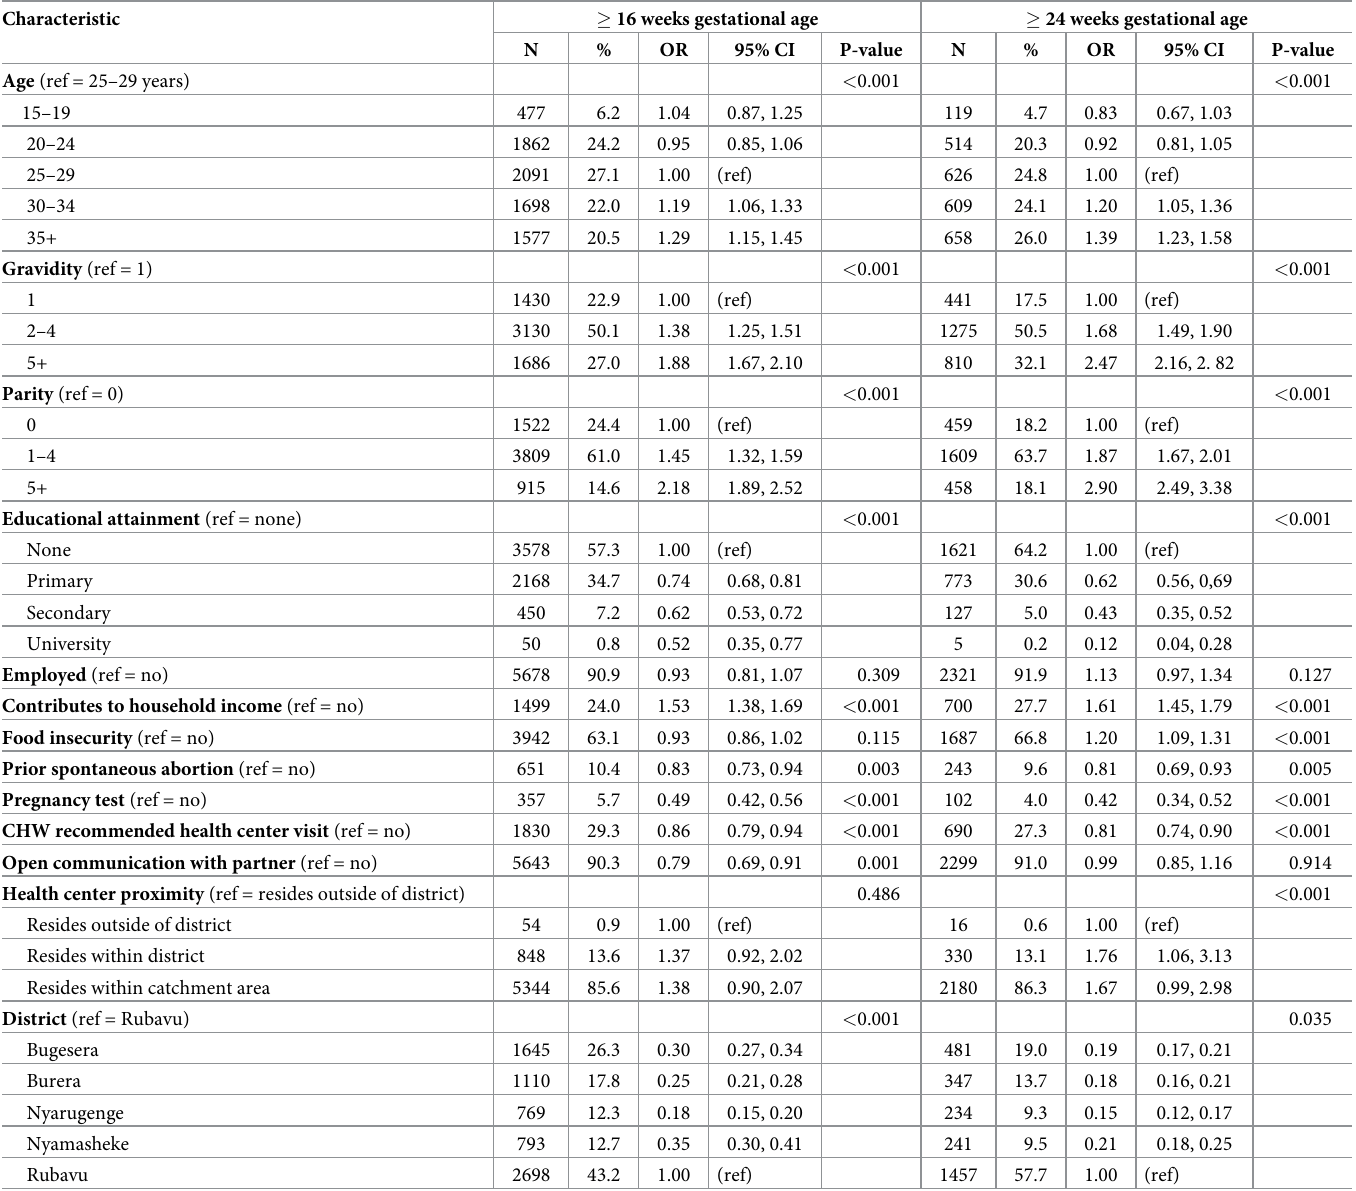
Table 1. Univariate relationships between sociodemographic factors and delayed antenatal